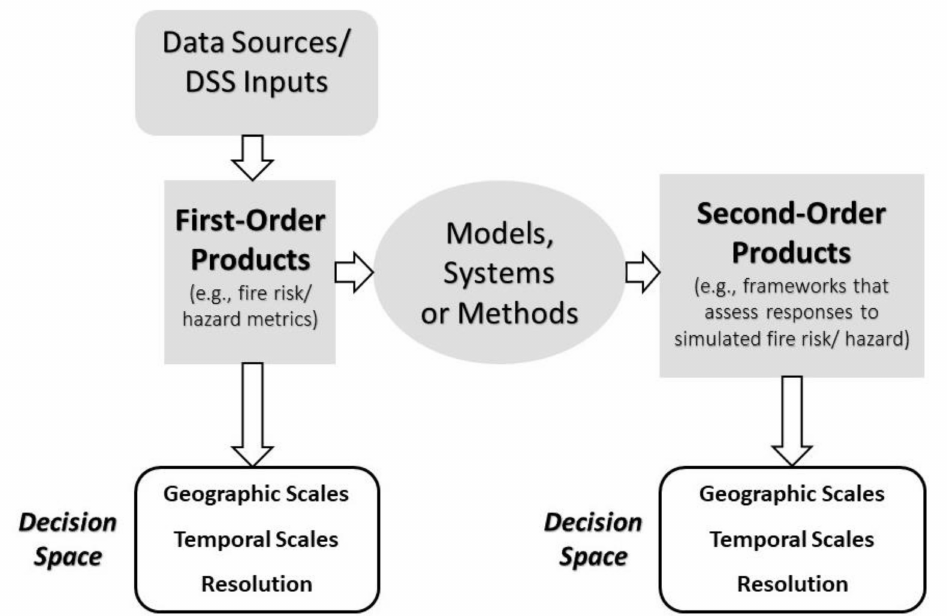
Figure 1. A framework for organizing spatial, pre-fire planning DSSs to support end-user under- standing and use of tools. Decision space (white boxes) refers to different decision contexts such as long-term, strategic planning; short-term, tactical planning; and scene-of-action